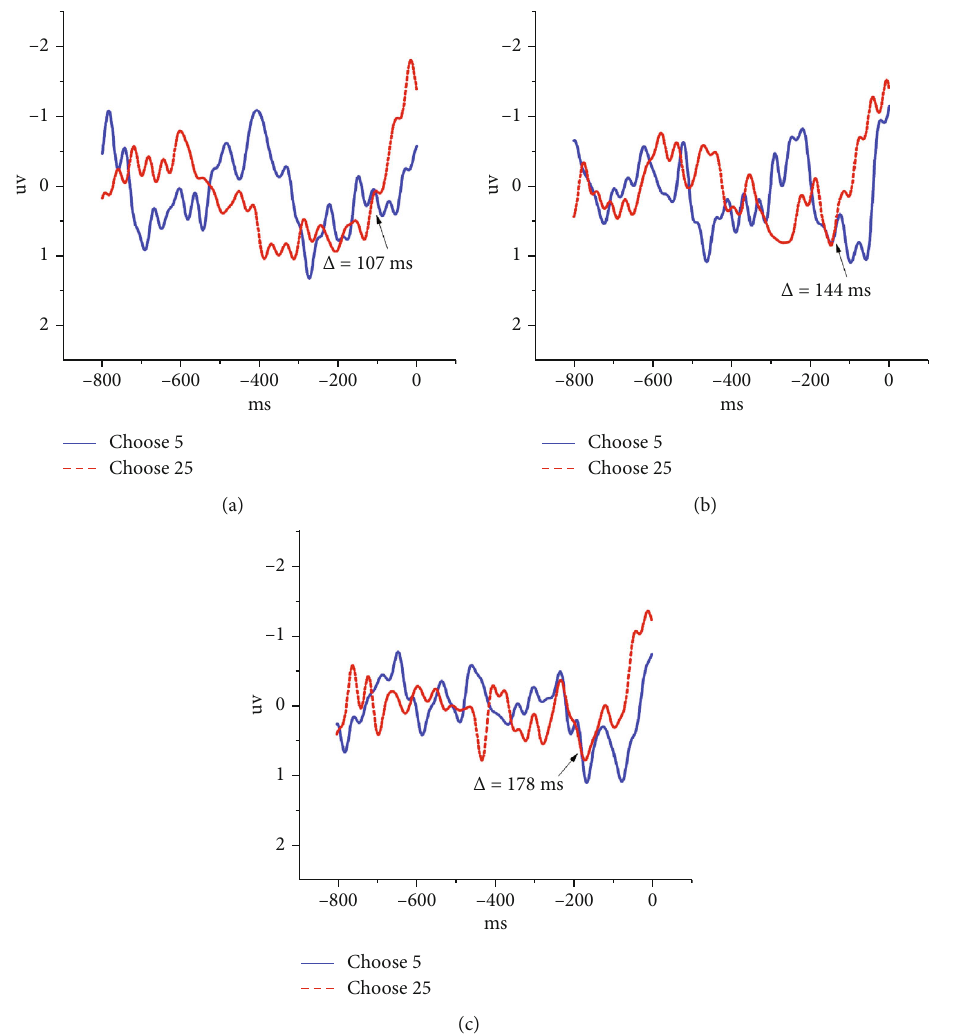
Figure 3: The EEG at Fz in every experiment before making the decision. The PT increases with the parameter E . (a) In the fi rst experiment ( E = 5 ), the PT is 107 ms. (b) In the second experiment ( E = 7 ), the PT is 144 ms. (c) In the third experiment ( E = 10 ), the PT is 178ms.